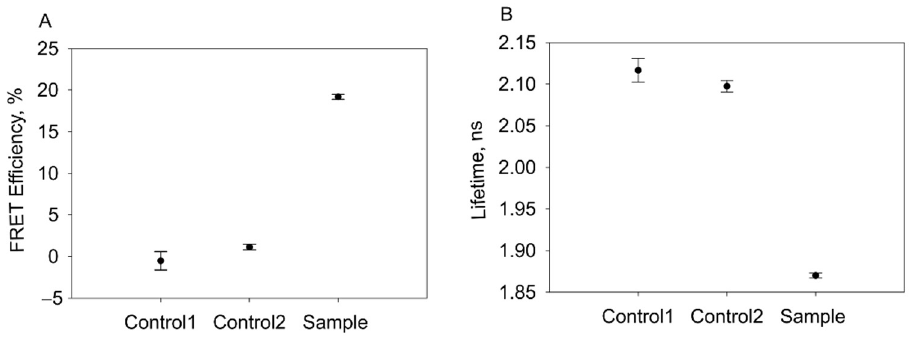
Figure 8. ( A ) FRET efficiency in nanotubes and ( B ) change in mean fluorescence lifetime in nano- tubes. Control 1–041 Δ 200GFP, Control 2–041 Δ 200GFP mixed with 041 Δ 200mCherry (1:1), sample– 041 Δ 200GFPmCherry nanotubes.